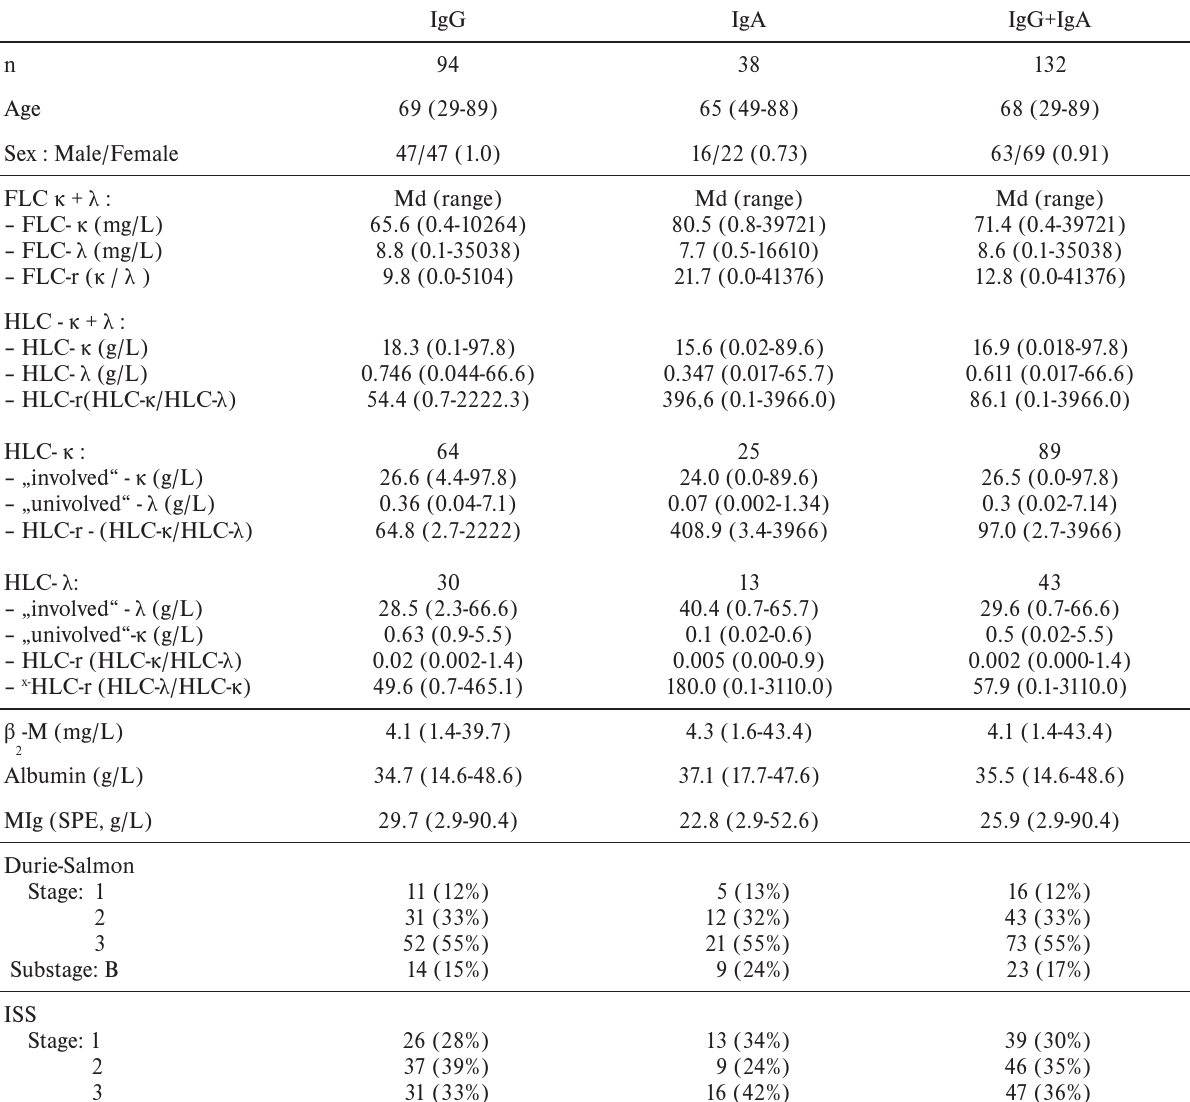
Table 1. Basic characteristics of the analyzed groups of patients with multiple